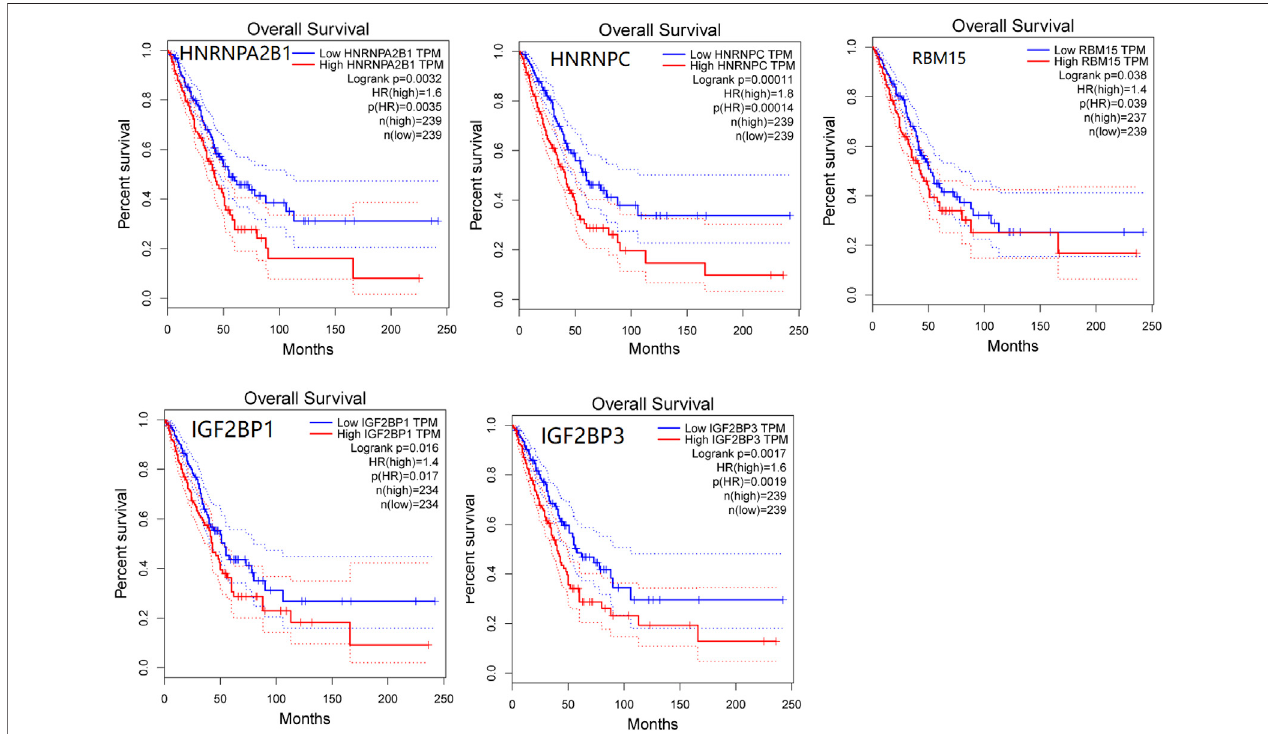
FIGURE 3 | Survival analysis of m 6 A modi fi cation regulators in LUAD patients by the GEPIA database. Five genes that have signi fi cant association with poor prognosis of LUAD were presented ( p < 0.05).